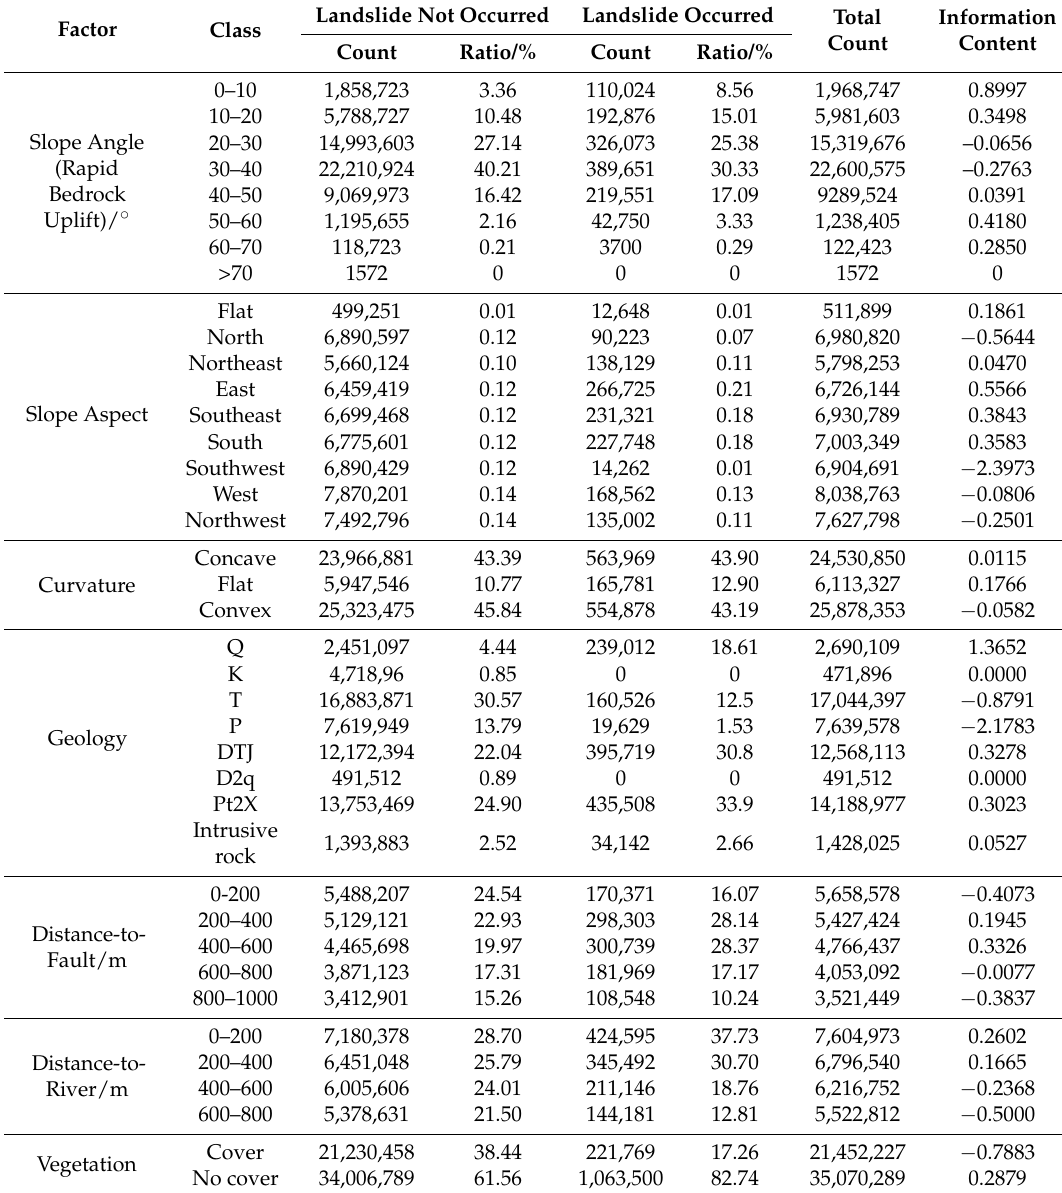
Table 4. Distribution of the training